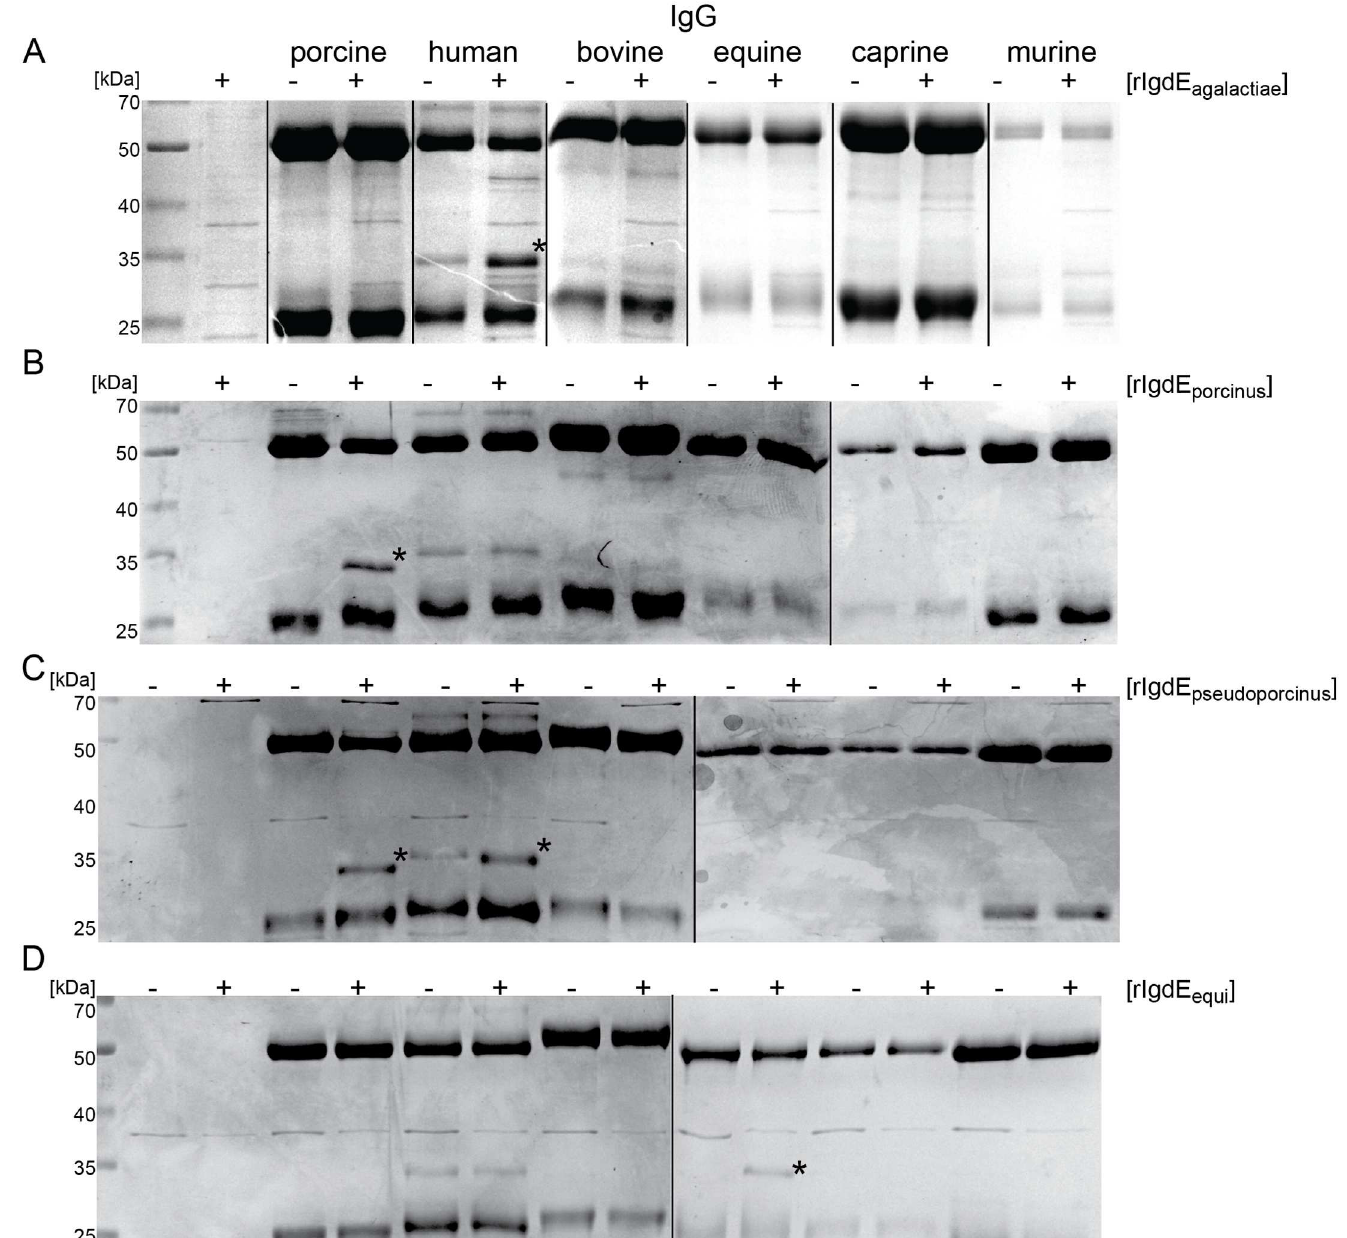
Fig 2. IgG host species specificity of IgdE family proteases. 0.5 mg/ml human, porcine, equine, bovineand murine IgG were incubatedfor 16h at 37˚C with (A) 20 μ g/ml purified rIgdE agalactiae , (B) 20 μ g/ml purifiedrIgdE porcinus , (C) 5% soluble fraction of E . coli cells expressing rIgdE pseudoporcinu s, (D) 5% solublefraction of E . coli cells expressing rIgdE equi . PBS (A and B) or 5% solublefraction of E. coli cells without recombinant construct (C and D) were used as negative controls (-). Reactions were analyzedby Coomassie blue SDS-PAGE under reducing conditions. Images of different SDS-PAGE run in parallelhave been assembledinto one figure. The diagnostic 32 kDa IgG cleavageproduct ( * ) appearedwhen rIgdE agalactiae was incubated with human IgG, rIgdE porcinus with porcineIgG, rIgdE pseudoporcinus with human IgG and porcine IgG, and rIgdE equi with equineIgG.